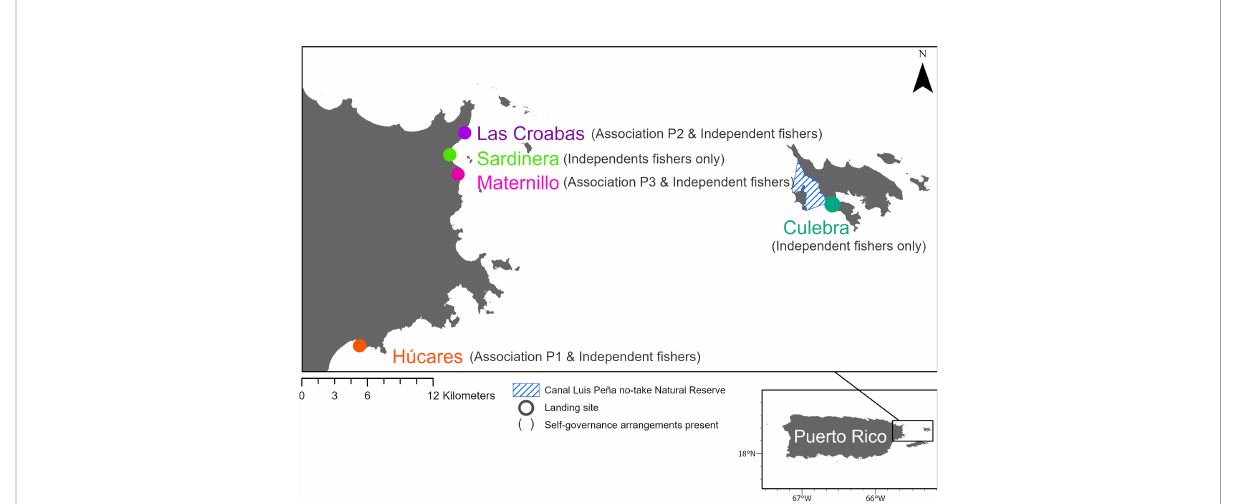
FIGURE 1 Map of the study site in north-eastern Puerto Rico highlighting the commercial fi sher ’ s self-governance arrangements ( fi shing associations vs. independent fi shers) found in each landing site. While all sites have independent fi shers operating in them, Las Croabas (CRO), Hu ́ cares (HUC), and Maternillo (MAT) also have fi shing associations. Culebra (CUL) and Sardinera (SAR) only have independent fi shers. Although associations sometimes had members who operated in other landing sites, their fi sh shops and administration were based on one of the landing sites. Association P1 was based in Hu ́ cares. Association P2 was based in Las Croabas, and Association P3 was based in